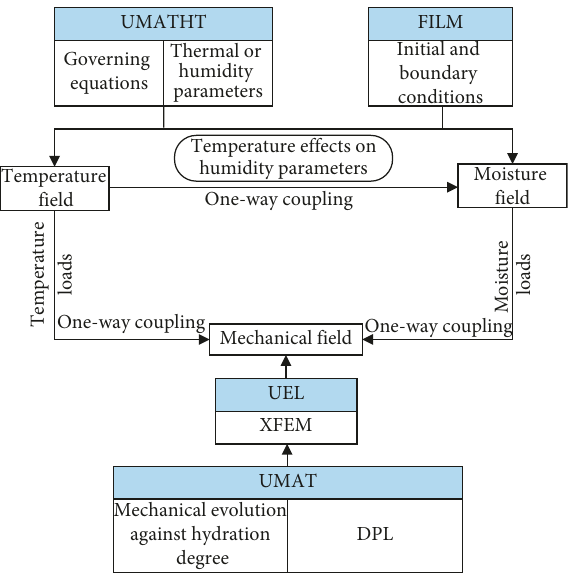
Figure 2: Development of concrete strength with time.